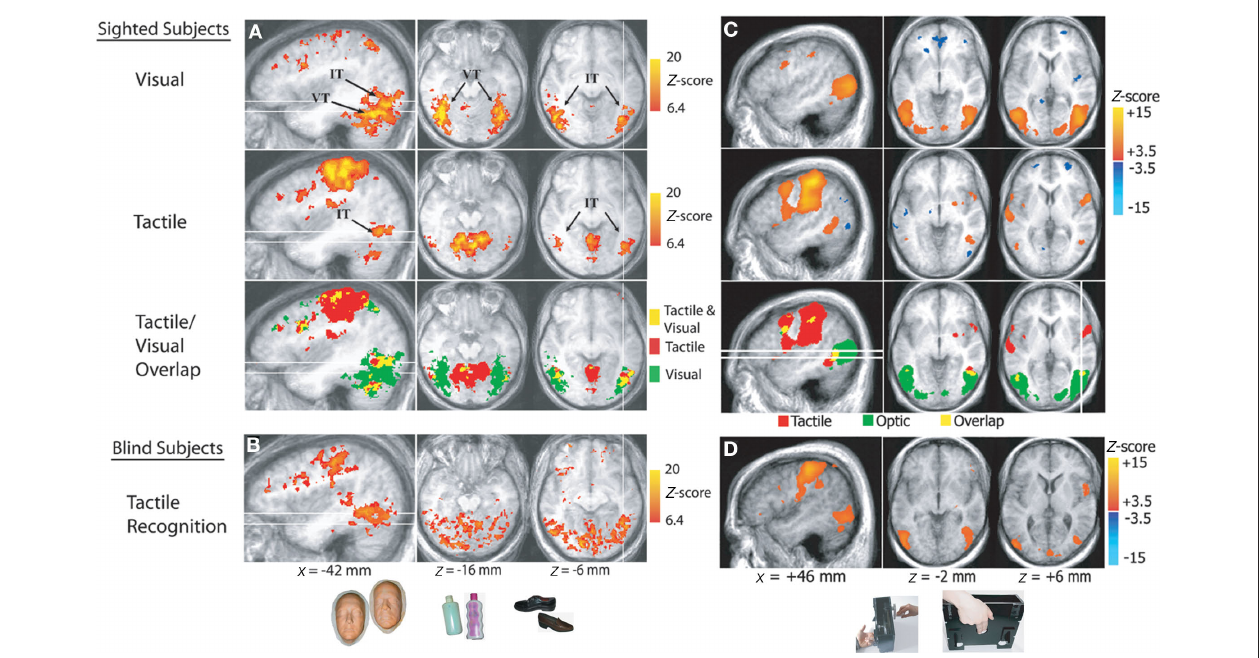
The white lines correspond to the locations of the sagittal and axial slices. (C,D) Supramodal neural response in hMT + cortex. Braille-like dot patterns moved on a plastic surface to provide translational and rotational tactile flow stimulation. Subjects’ hands lay on the table with the index and middle fingers touching the plastic surface with dot patterns, as shown at the bottom of the picture. Brain areas are shown that responded during tactile or optic flow perception in sighted subjects and during tactile flow perception in blind subjects. The tactile/visual overlap map shows the areas activated by both tactile and optic flow perception (shown in yellow), as well as the areas activated only by tactile (red) and optic (green) perception (modified from Pietrini et al., 2004; Ricciardi et al.,